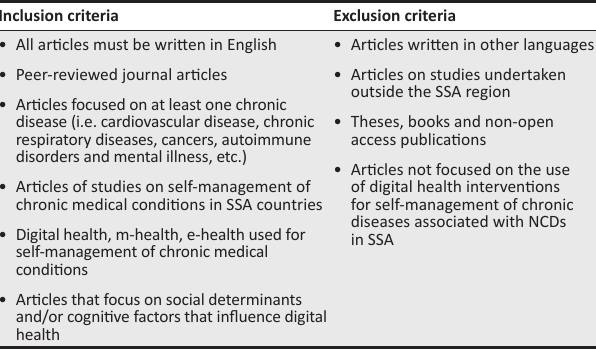
TABLE 2: Inclusion and exclusion